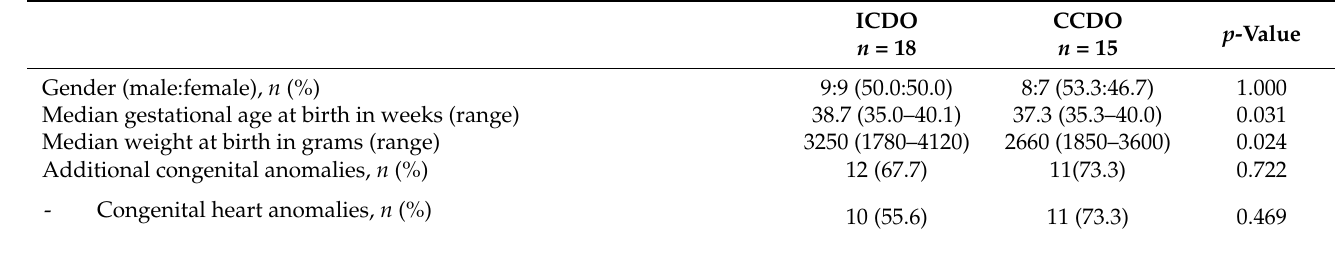
Table 1. Demographics of patients with incomplete and complete duodenal